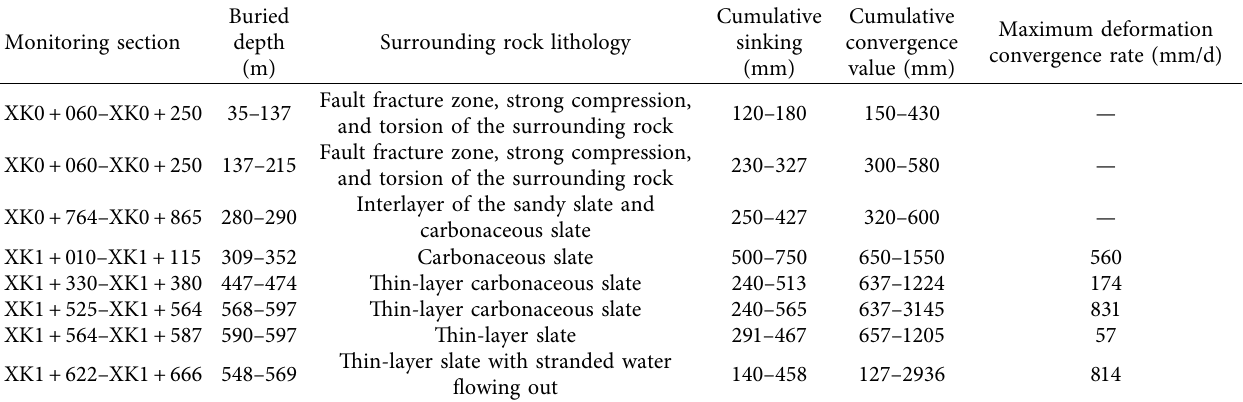
Figure 4: Damage characteristics of the surrounding rock of the tunnel: (a) severe drip of water in the middle steps on the left, (b) severe deformation of the arch, and (c) large deformation of the local vault. Table 5: Results of the monitoring of the initial support of the